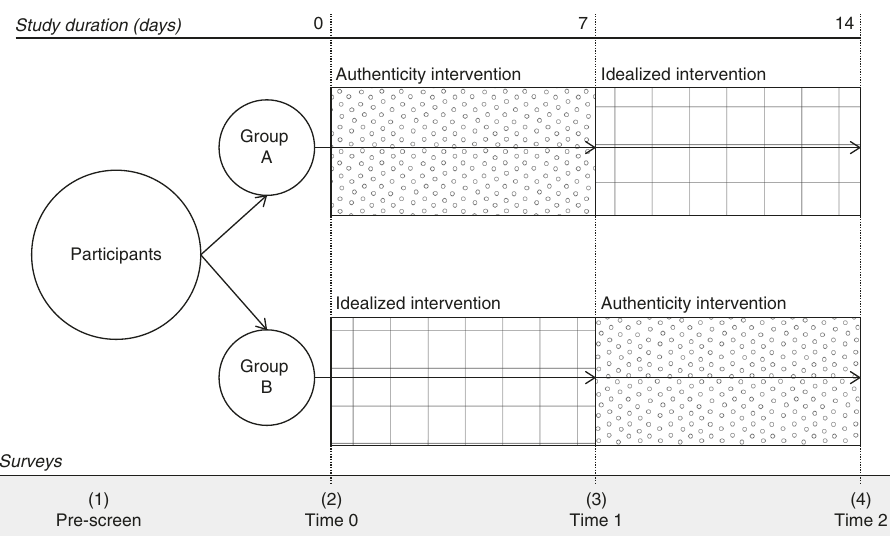
Fig. 2 Study 2 experimental design. Figure 2 presents the longitudinal experimental study design for Study 2 with key timepoints, interventions, and